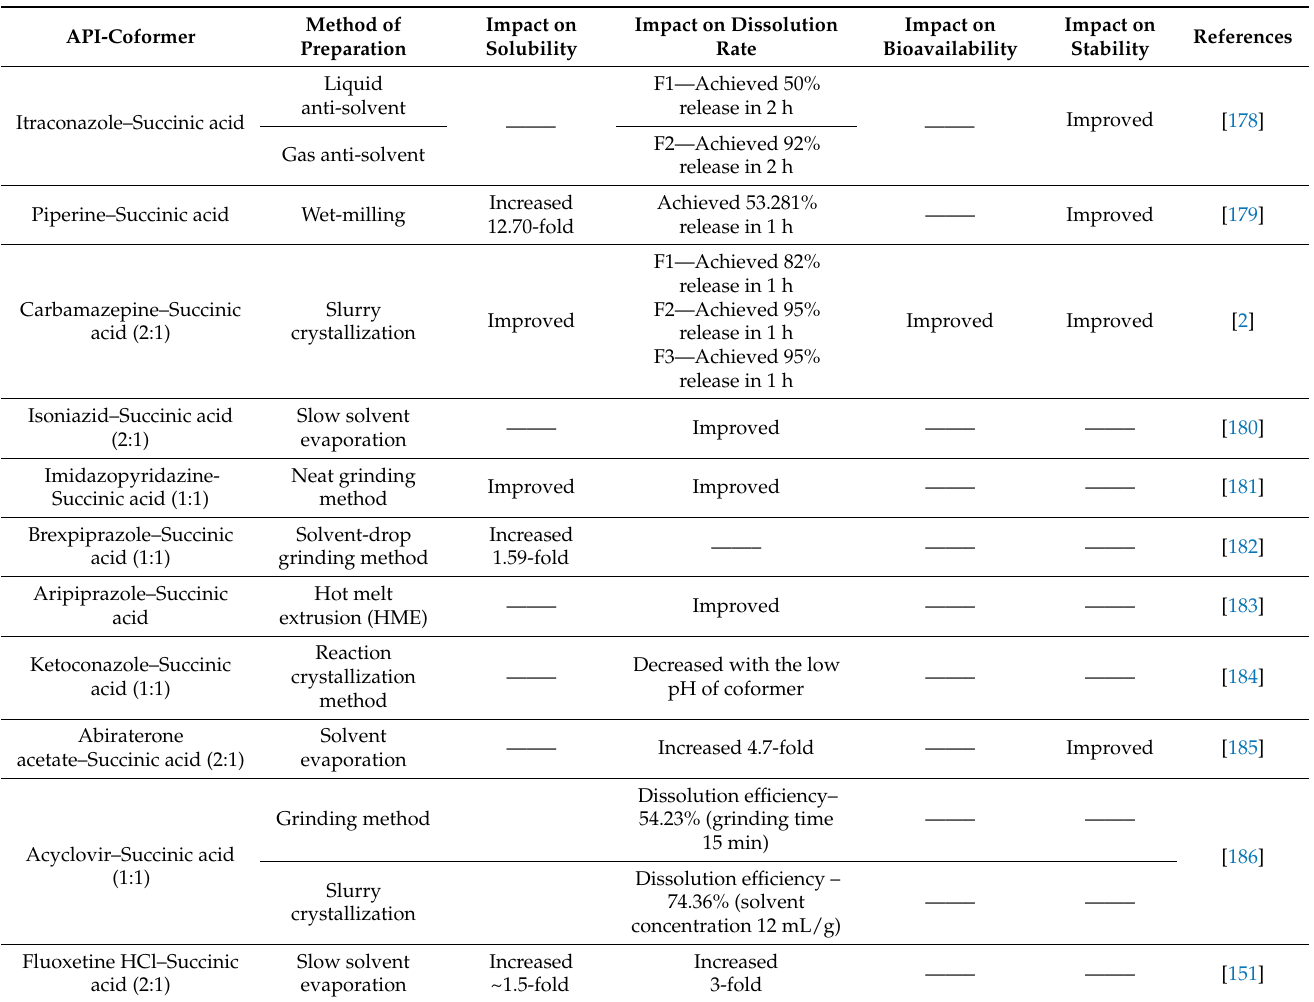
Table 10. Impact of succinic acid as a coformer on